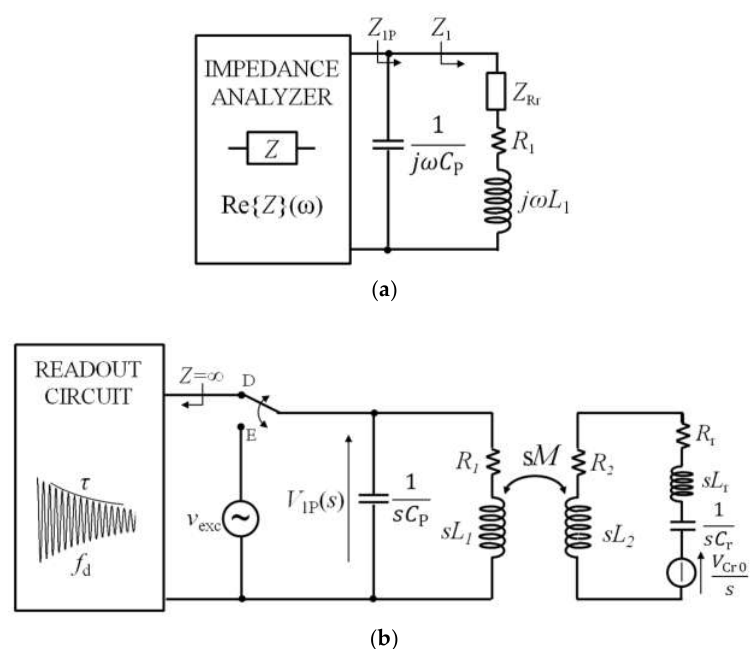
Figure 12. ( a ) Block diagram of the interrogation system with equivalent circuit of the impedance Z 1P for the technique based on impedance measurements applied to an electromechanical piezoelectric resonator; Z Rr represents the reflected impedance of the RSU with electromechanical piezoelectric resonator. ( b ) Block diagram of the interrogation system with equivalent circuit in the Laplace domain to derive V 1P ( s ) during the detection phase of the time-gated technique applied to an electromechanical piezoelectric resonator.